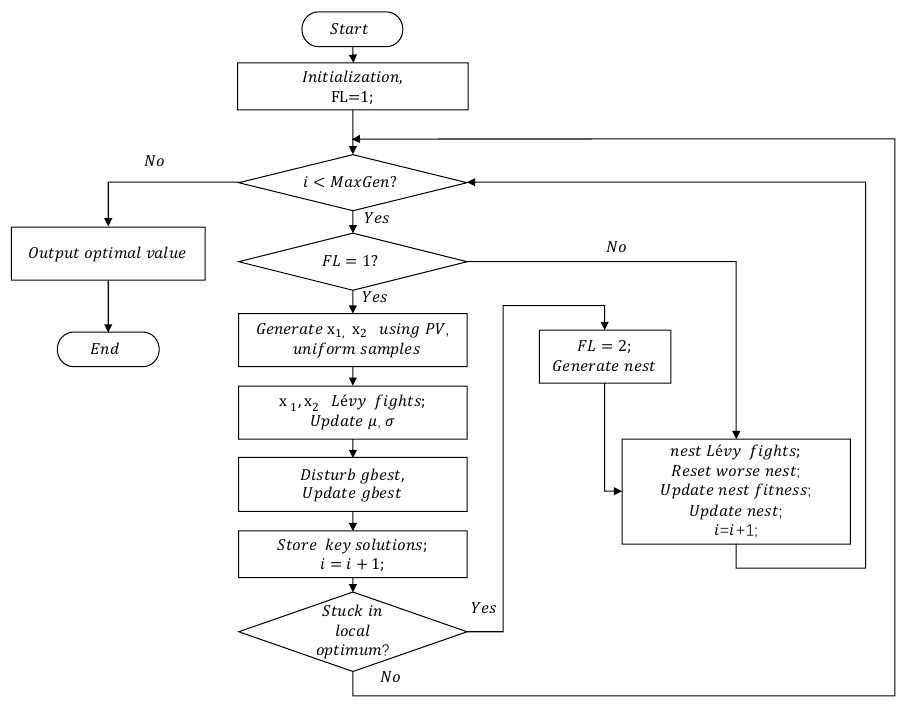
Figure 2. The overall flow chart of